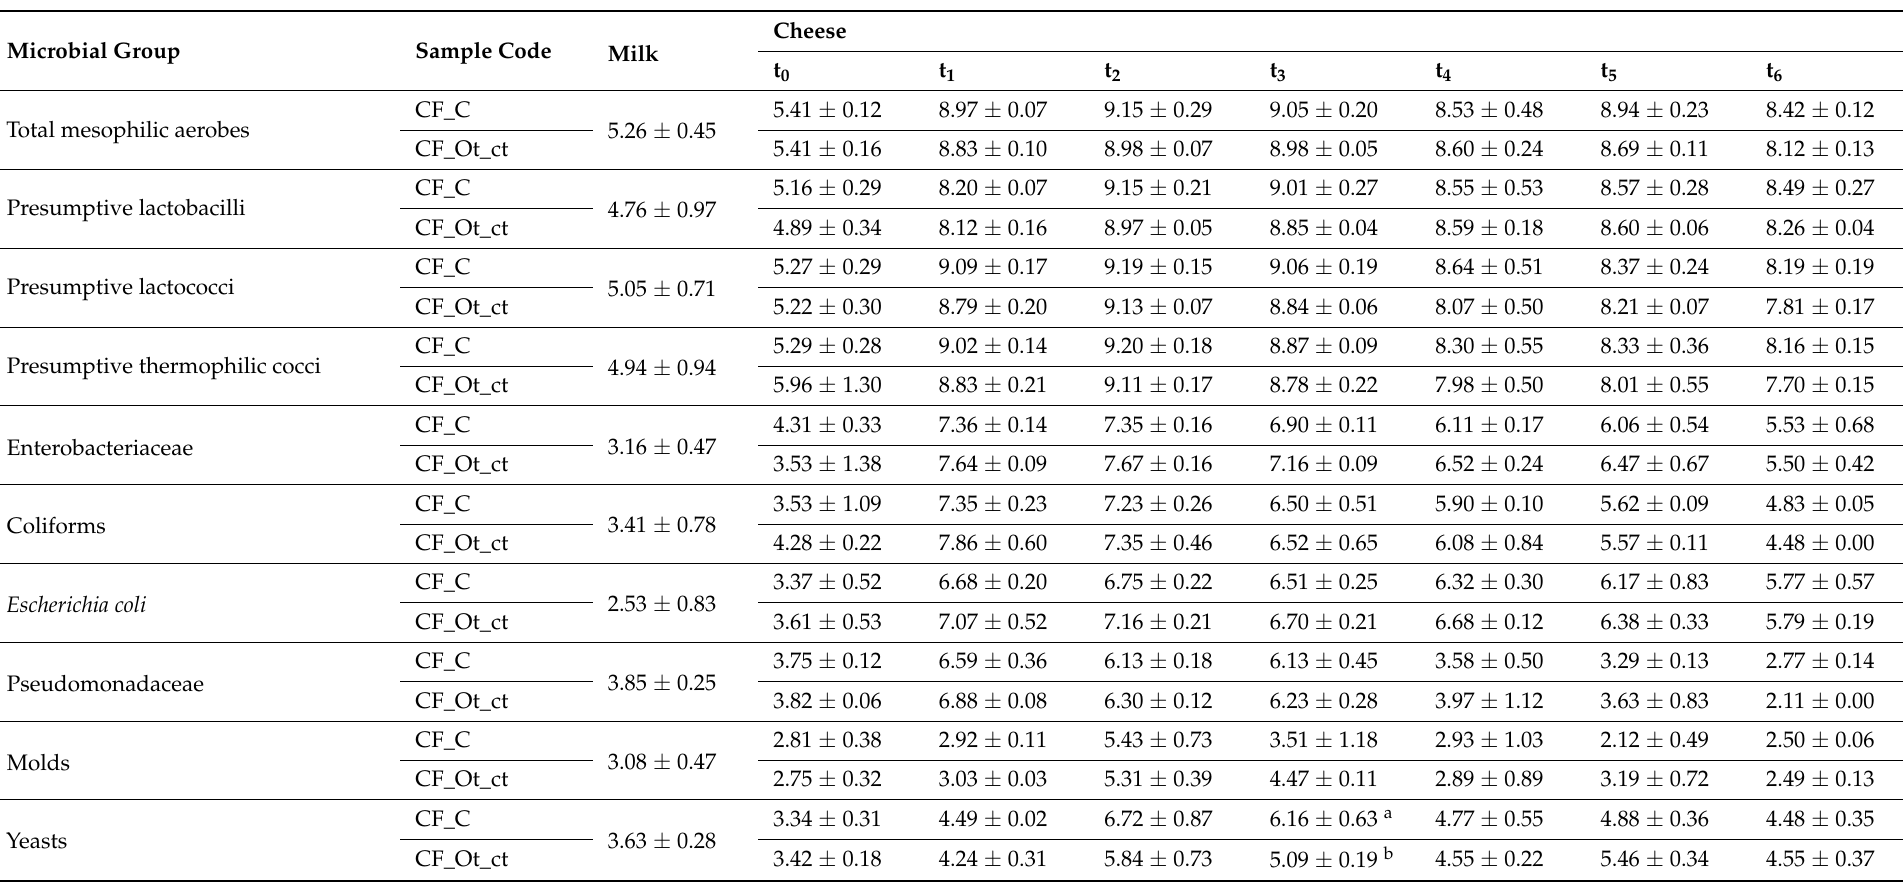
Table 3. Viable counts of milk used in the second cheesemaking round (R2_M), and control (CF_C), and experimental (CF_Ot_ct) Caciofiore cheeses sampled during